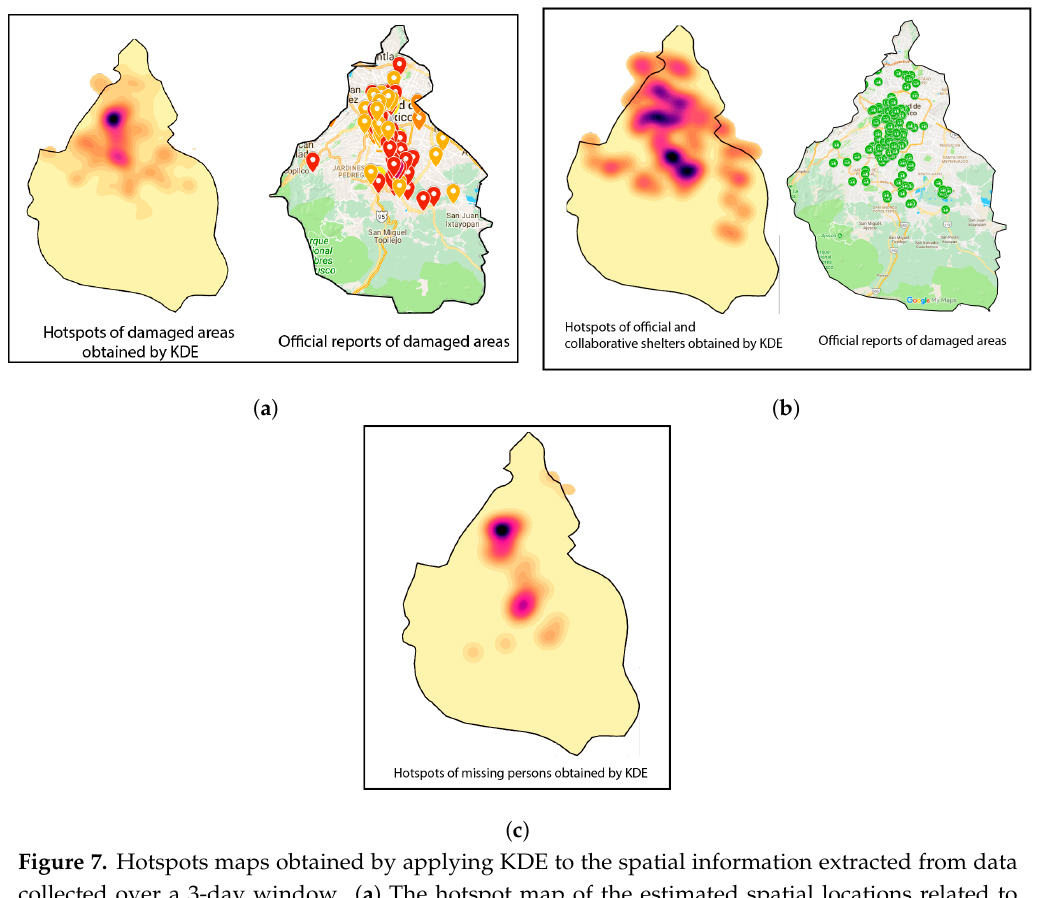
Figure 7. Hotspots maps obtained by applying KDE to the spatial information extracted from data collected over a 3-day window. ( a ) The hotspot map of the estimated spatial locations related to damages and collapses and official reports. ( b ) The hotspot map of estimated spatial locations related to official and collaborative shelters and official reports. ( c ) The hotspot map of estimated spatial locations related to missing persons (there are no official reports of missing